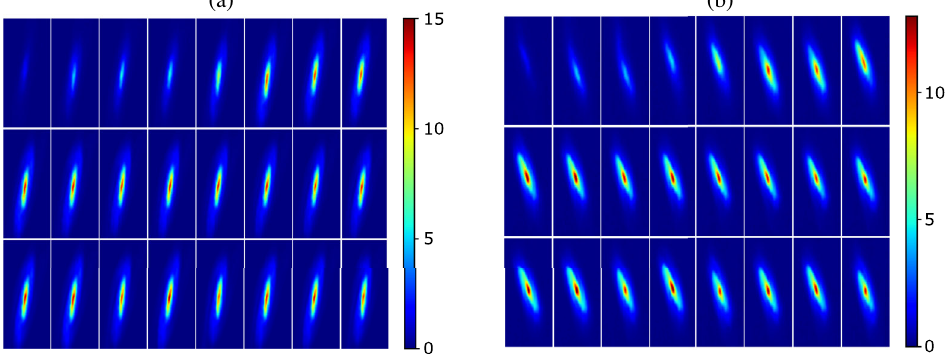
FIG. 13. Measured 24 slices of the phase space distributions along the rising edge of the 1.4-MW H − beam minipulse. The time difference between emittance slices is ∼ 3 . 3 ns. (a) Horizontal phase space. (b) Vertical phase space.